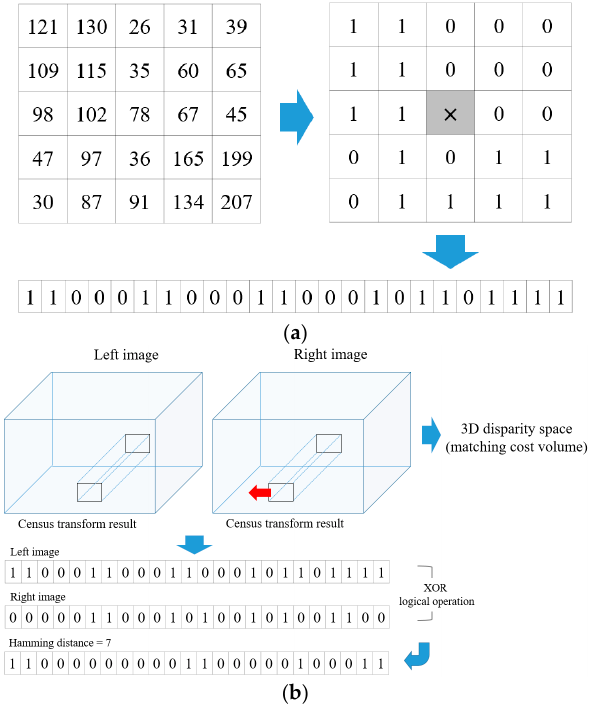
Figure 2. ( a ) Example of census transform; ( b ) Its hamming distance result.